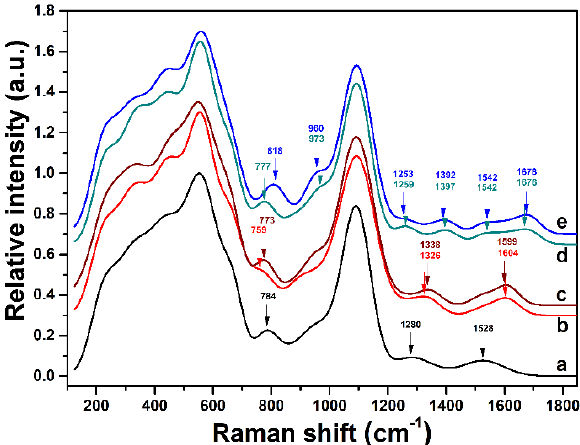
Figure 5. Normalized Raman spectra for ITO electrodes that are fabricated using ( a ) b-PM, ( b ) HbA0 aptamer, ( c ) HbA1c aptamer, ( d ) HbA0, and ( e ) HbA1c at the top. The HbA0 aptamer and HbA1c aptamer are coated on the ( a ) surface to yield surfaces ( b ) and ( c ). Surfaces ( b ) and ( c ) are then used to capture HbA0 and HbA1c on top to yield surfaces ( d ) and ( e ), respectively.